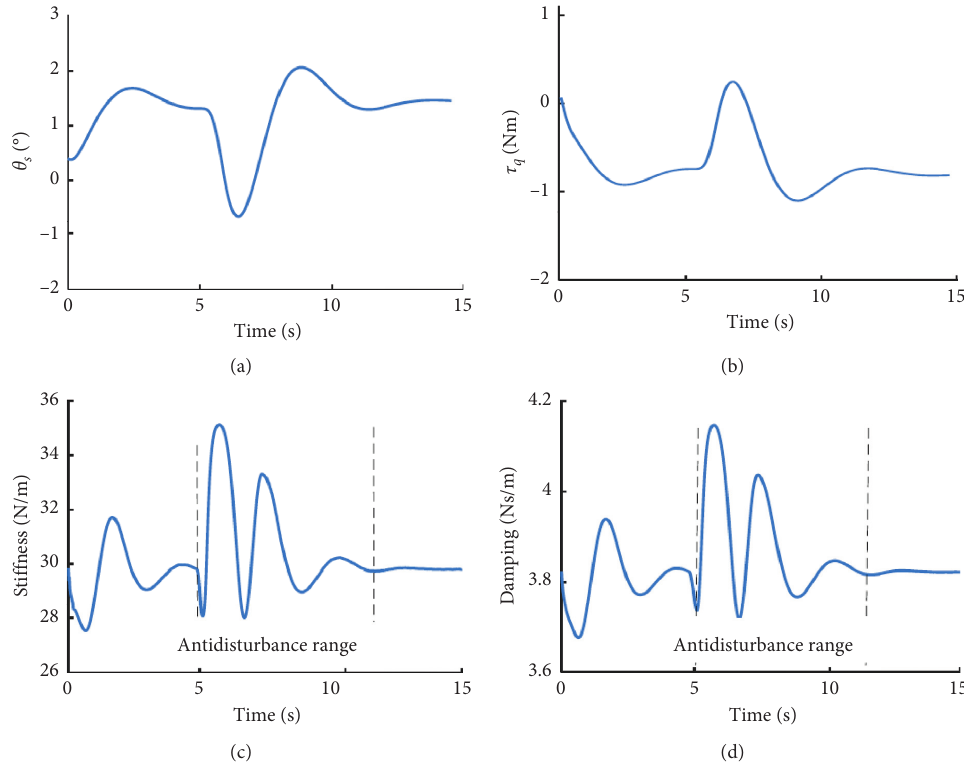
Figure 5: The simulation results of bipedal robotic standing balance control (0.5m/s 2 ). (a) Tilt angle. (b) Ankle torque. (c) Ankle stiffness. (d) Ankle damping.